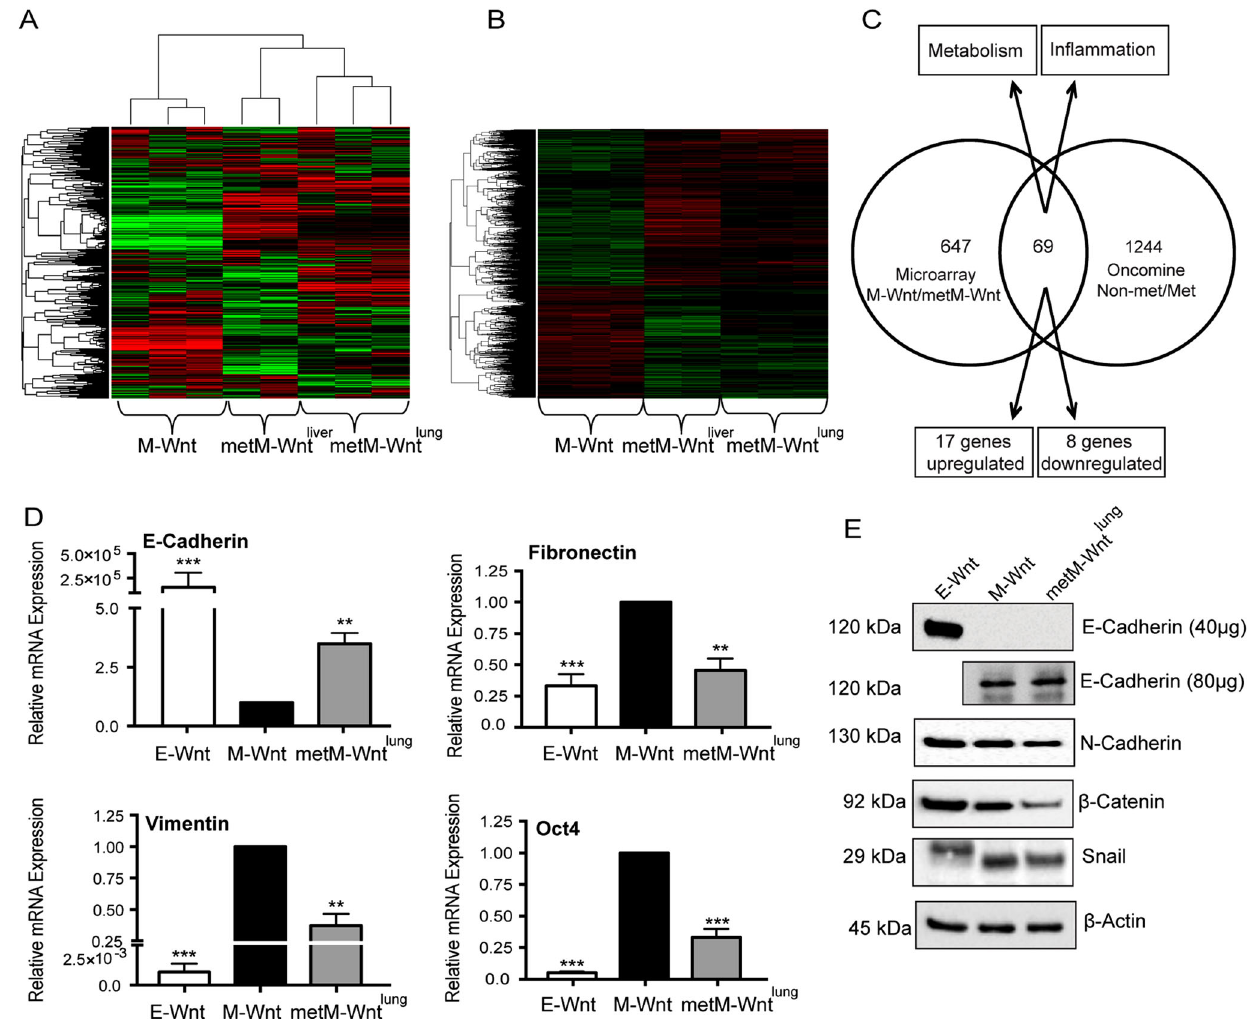
Fig. 3 Gene expression analysis of metastatic vs. nonmetastatic M-Wnt cells and comparison with human metastatic breast cancer. a Heat map showing the top 5000 most variable probes in M-Wnt, metM-Wnt lung and metM-Wnt liver cells. b Heat map showing signi fi cantly different gene expression in metM-Wnt cell metM-Wnt lung ) and metM-Wnt liver cells ( q < 0.001, FC > 3 or FC < 0.33) compared with nonmetastatic M-Wnt cells. c Venn diagram showing overlap between signi fi cantly different gene expression in metM-Wnt cells ( p < 0.05, q < 0.001, FC > 3 or FC < 0.33) compared with nonmetastatic M-Wnt cells with comparisons of primary and metastatic breast cancer datasets in Oncomine ( p < 0.001). d RNA expression of EMT-related genes in E-Wnt, M-Wnt and metM-Wnt lung cells. Graphs show mean ± SD. * p < 0.05, ** p < 0.01, *** p < 0.001, Student ’ s t -test. e Representative immunoblots showing protein expression of E-cadherin and N-cadherin, Snail and β -Catenin in E-Wnt, M-Wnt and metM-Wnt lung cells, with β -Actin as a loading